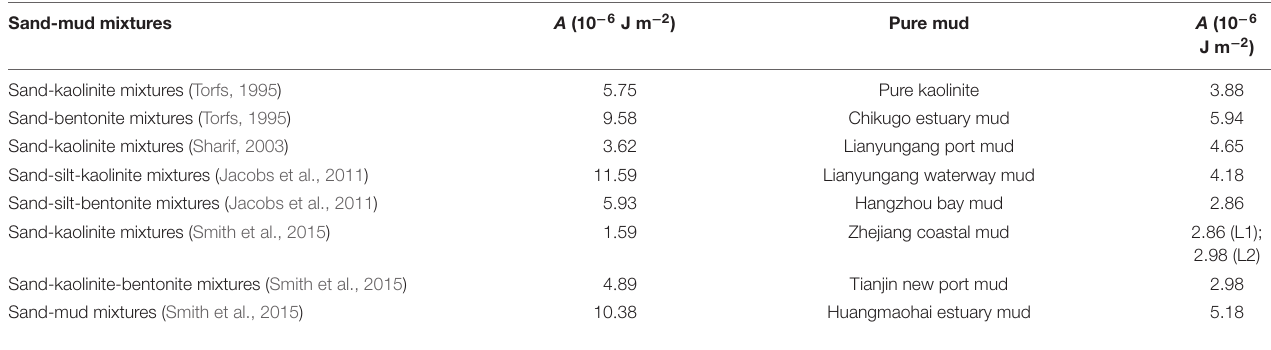
TABLE 3 | Application results of the developed formula in sand-mud mixtures and pure muds. Sand-mud